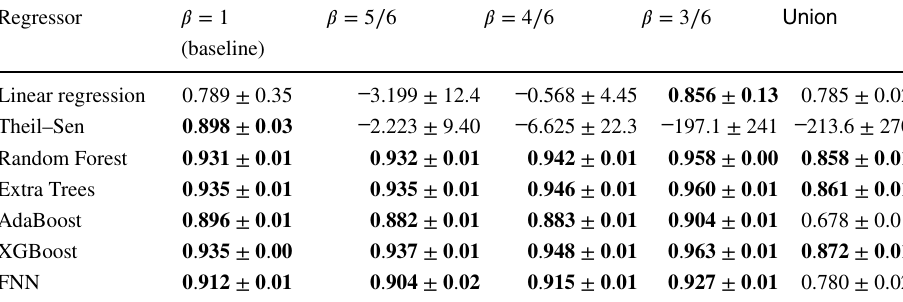
Union stands for the benchmark composed of the union of the other